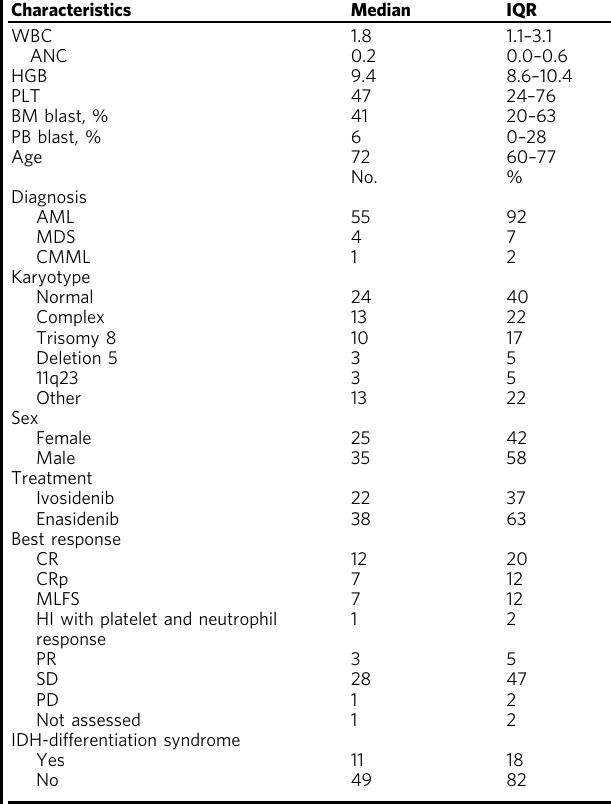
Table 1 Clinical characteristics of the 60 patients treated with IDH